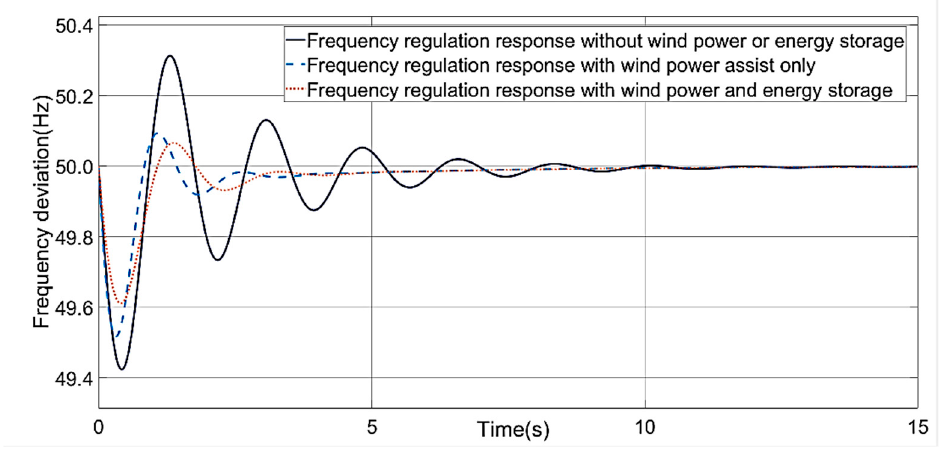
Table 6. Frequency characteristics comparisons of frequency regulation